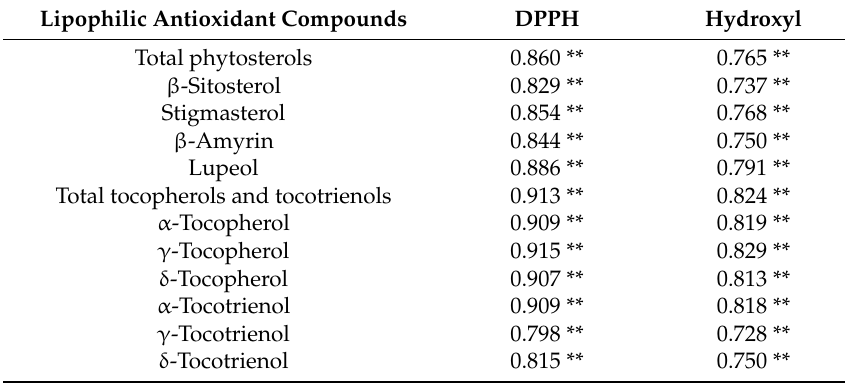
Table 6. Correlation between free radical scavenging capacity and beneficial lipophilic antioxidant compounds content in EDS